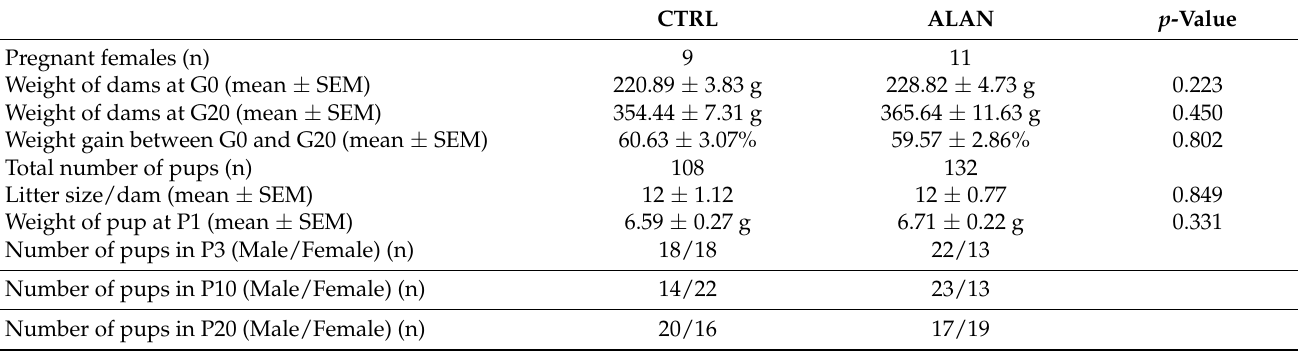
Table 4. Parameters of pregnant dams and characteristics of their pups until postnatal day 1. Dams were maintained either under a control light-dark cycle (CTRL) or at dim light during the night